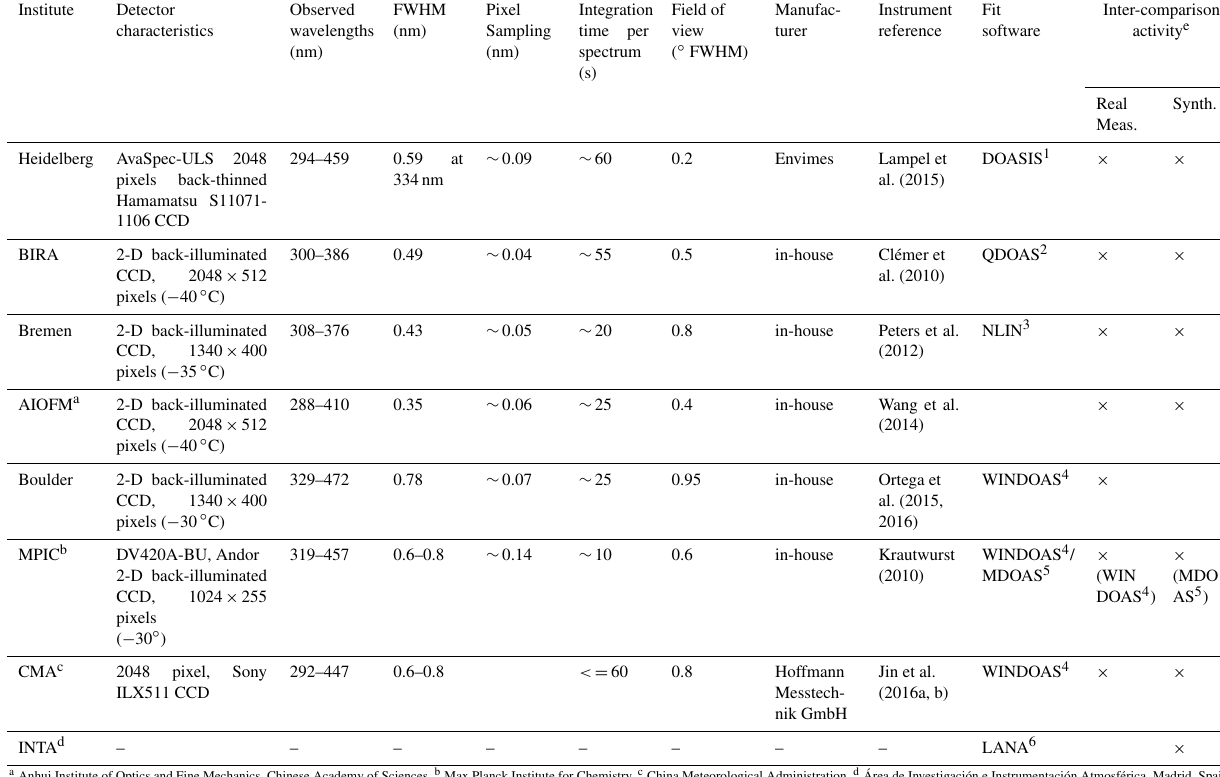
Table 1. Overview on instrumental properties and analysis software used by the different institutes participating in the HONO comparison